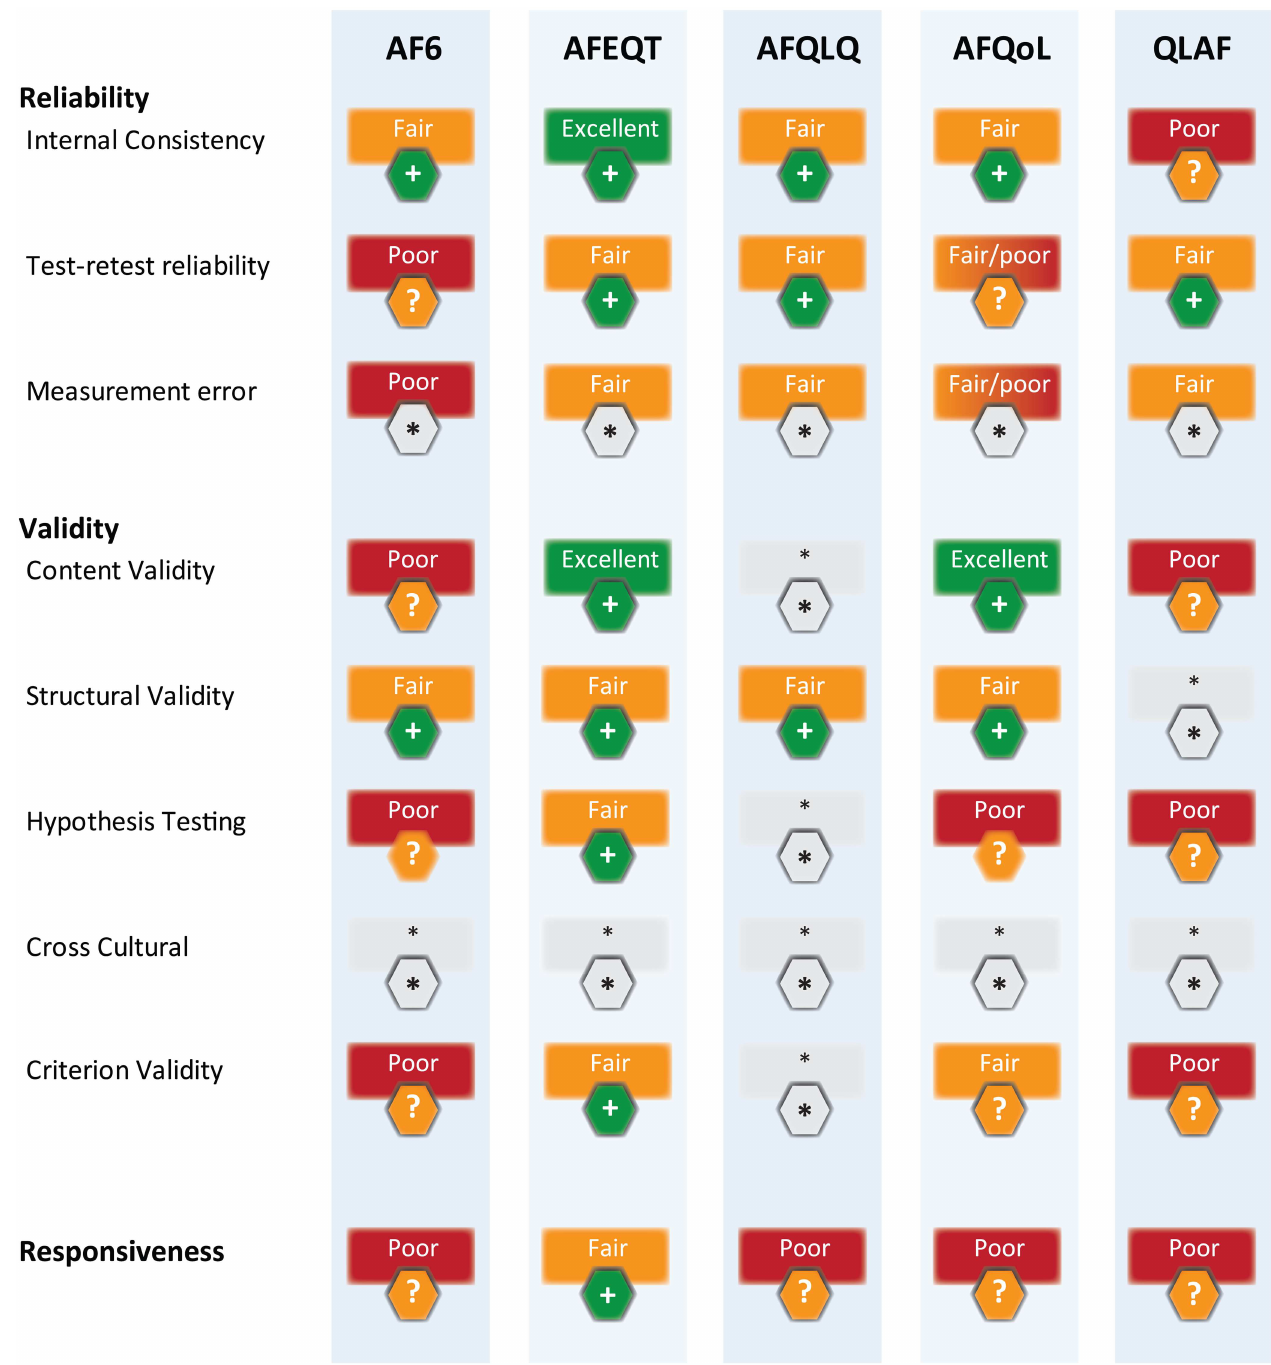
Fig 2. Summary of assessment. For each measurement property, the PROM is assessed for methodological quality of the study (excellent, good, fair or poor) and given an overall rating (positive [+], negative [-] or indeterminate/unknown[?]) for the results. A level of evidencewas applied,combiningthe number and quality of the studies with the strength of findings. Studies that have poor quality are given an ‘indeterminate /unknown’ rating due to the limited level of evidence. For AFQoL, reliabilitywas assessed differently in the two related studies. * Insufficient data were availableto rate this criterion. See Table 1 for assessment